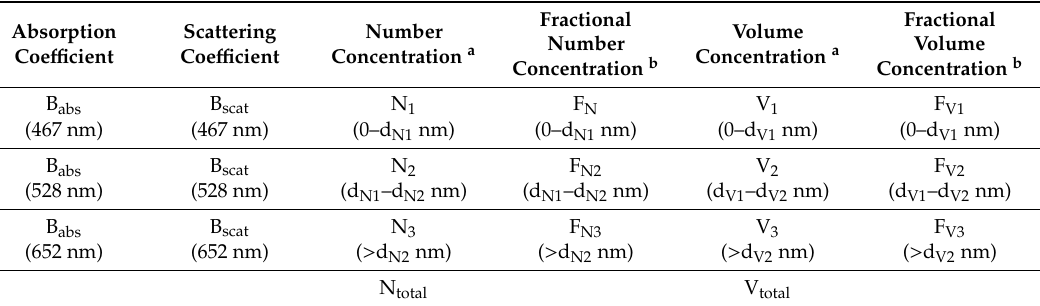
Table 2. Input variables in the